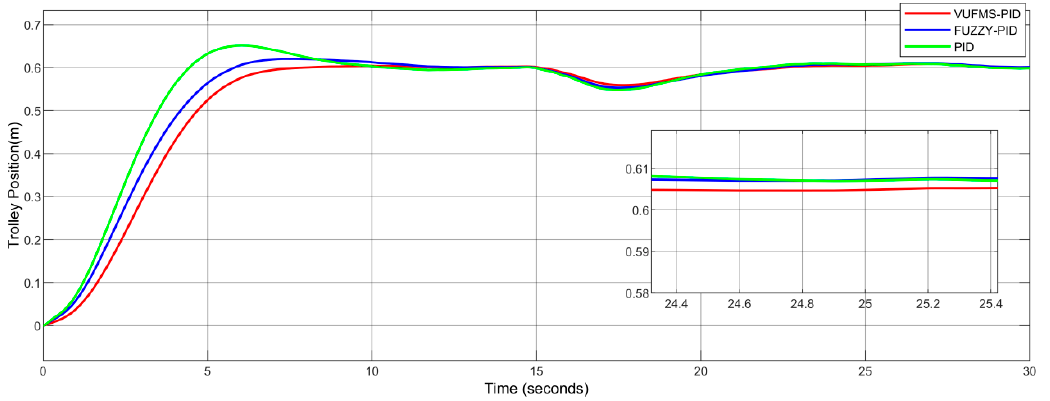
Figure 20. Payload’s swing angle using VUFMS-PID, FUZZY-PID and PID controller under working condition 3 with a crosswind and white noise.